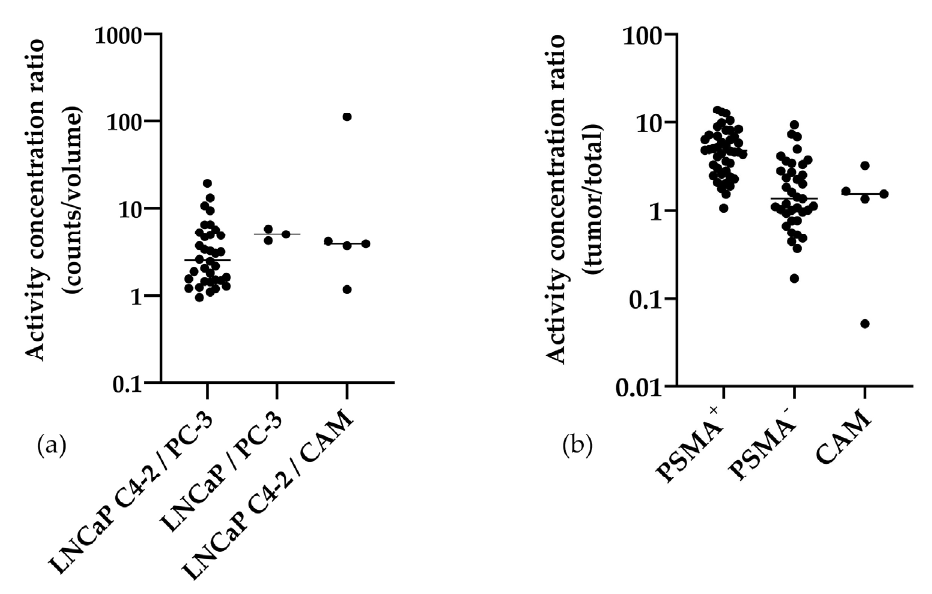
Figure 4. Scatter plots of the activity concentration ratios of the three experimental groups (PSMA + /PSMA - ) in logarithmic scale ( a ) and the activity concentration ratios of the tumor area and the total chick embryo ( b ). Each experiment is depicted as a single dot, the median is shown. Notably, all ratios but one had a value greater than 1 for the direct comparison of the tumor entities (a). All + in comparison to the total chick embryo were > 1 ( b values of PSMA + in comparison to the total chick embryo were >1 (b). All values of PSMA